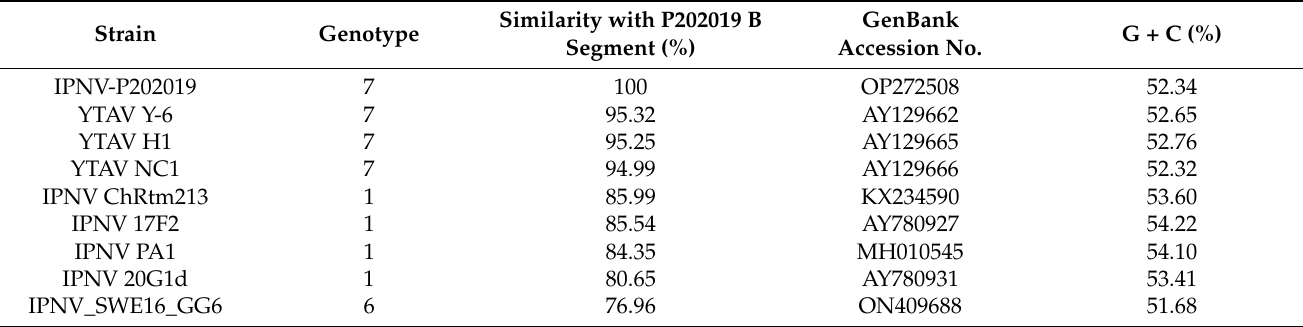
Table 2. Nucleotide identities for the full-length genome of IPNV-P202019 B segment. Similarity with P202019 B Strain Genotype Segment (%)